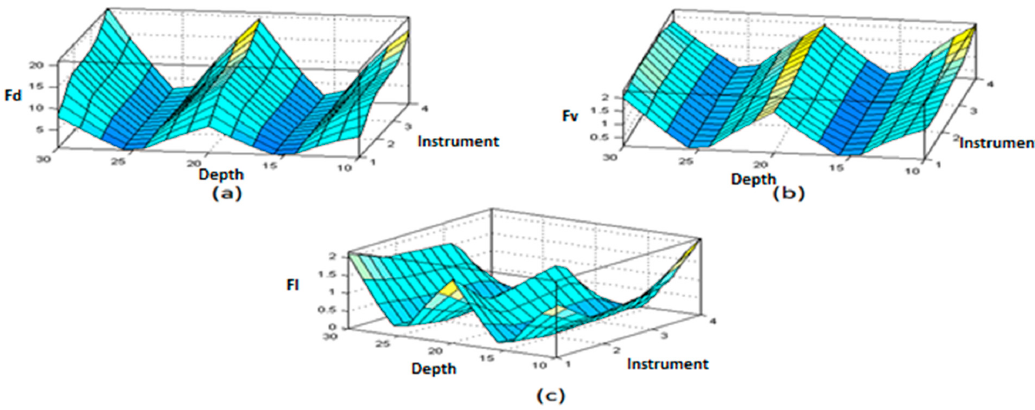
Figure 9. Surface graph showing the relationship of implements and depth with ( a ) draft force (Fd), ( b ) vertical force (Fv), and ( c ) lateral force (Fl).